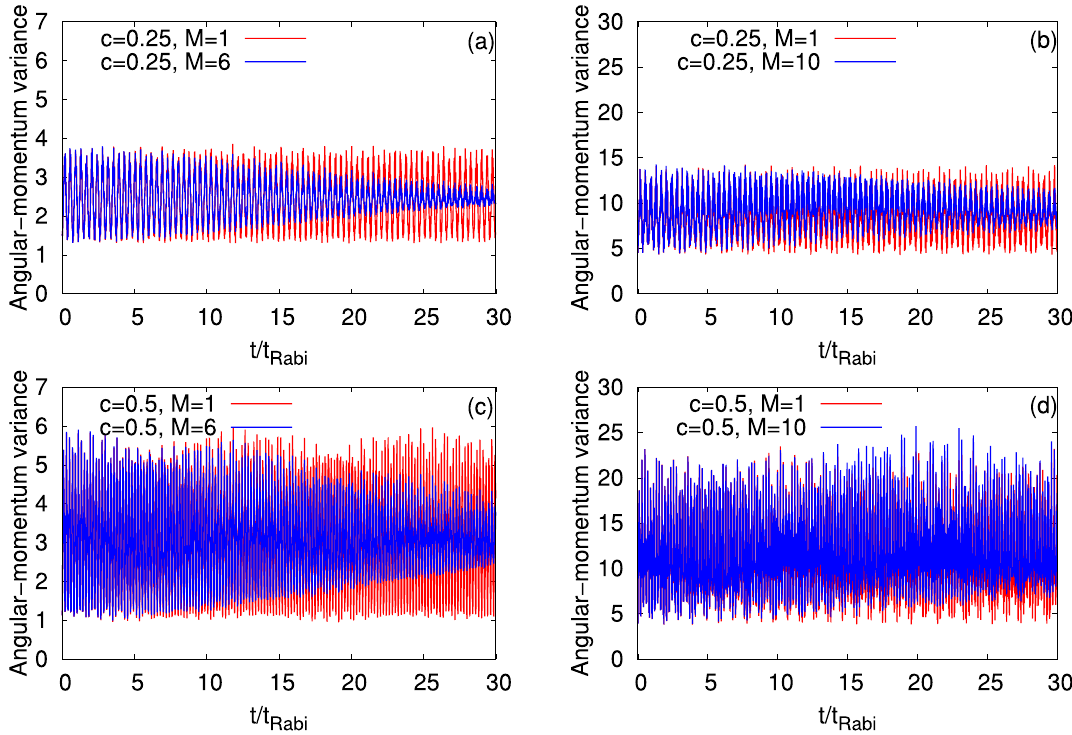
Figure 7. Time-dependent variance per particle of the z - component of the angular-momentum operator, 1 � 2 ( t ) , in a longitudinally-asymmetric 2D double-well potential for (cid:31) G (left column) and (cid:31) Y (right column) N L Z ˆ 10 bosons with the interaction parameter � of N = resonant tunneling with asymmetry parameter, c results. The many-body dynamics are computed with M time-dependent orbitals for (cid:31) Y . We show here dimensionless quantities. Color codes are explained in each